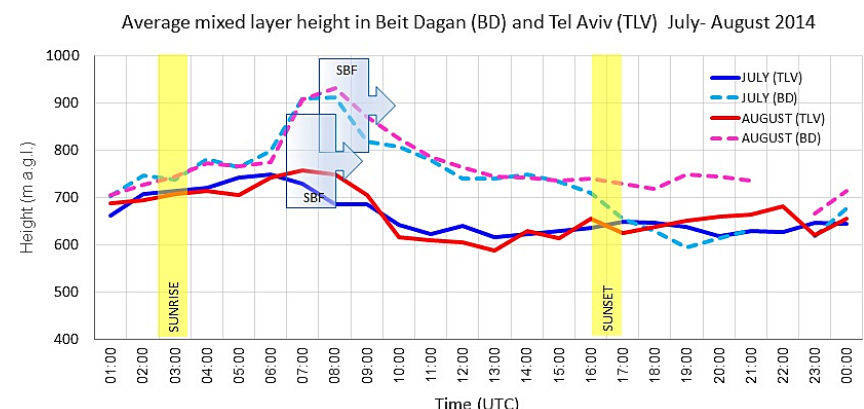
Figure 6. The hourly average of the eastern Mediterranean summer MLH, at the onshore site in Tel Aviv (solid lines) and the inland site in Beit Dagan (dashed lines,) between July (blue and pale blue lines) and August (red and pink lines) 2014. The MLH was evaluated by the CL31 ceilometer measurements at both sites, taken over 20 days in July and 24 days in August in the BD site, and 30 days in July and 30 days in August in the TLV site. Indications of the sunrise, sunset, and the SBF are given. Data provided from the BD site are comprised of 23h of measurements on UTC + 2 timescale; therefore in order to compare to the 24h of TLV site measured on UTC timescale, the hour of 22:00UTC is missing for BD measurements.